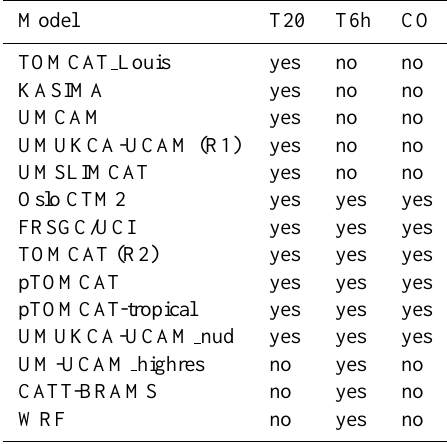
Table 3. The tracers included in the different model